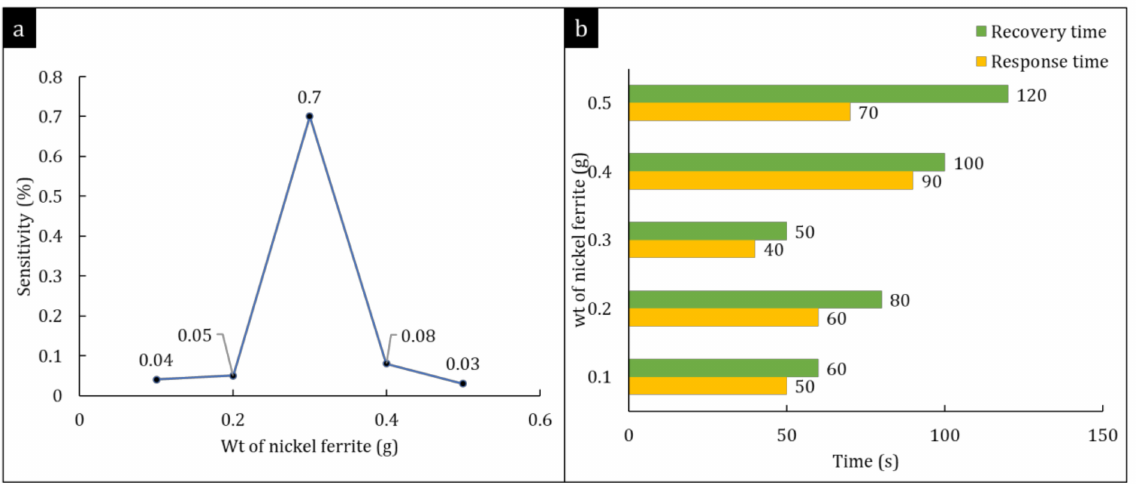
Figure 9. ( a ) Sensitivity of different amounts of nickel ferrite towards chlorine gas. ( b ) Response and recovery time of different hybrid